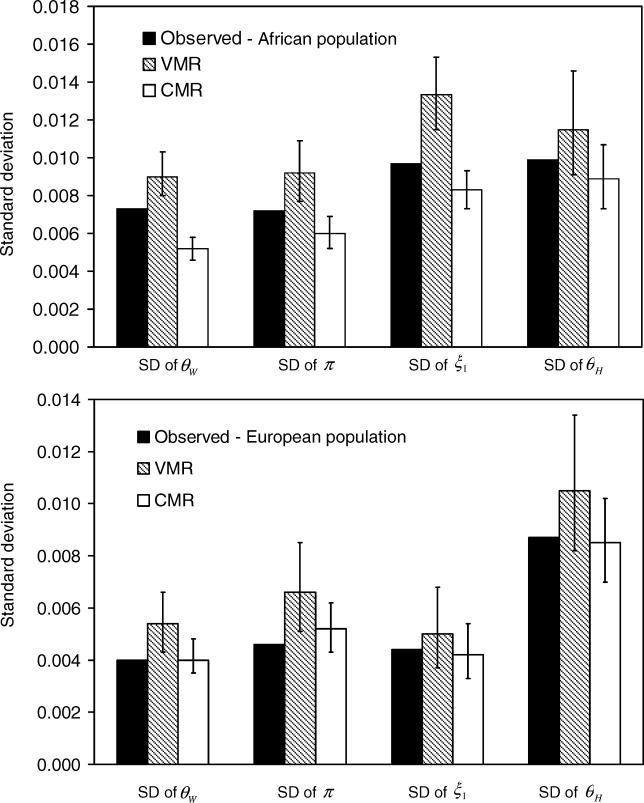
Evaluation of the Demographic Scenarios for the African and European PopulationsThe standard deviation (SD) of a summary statistic is calculated as the standard deviation among loci. The values of the solid bars are obtained from the data. VMR, varying mutation rate model; CMR, constant mutation rate model. The 95% CI of the SD of each summary statistic obtained from 103 simulated datasets is also given.